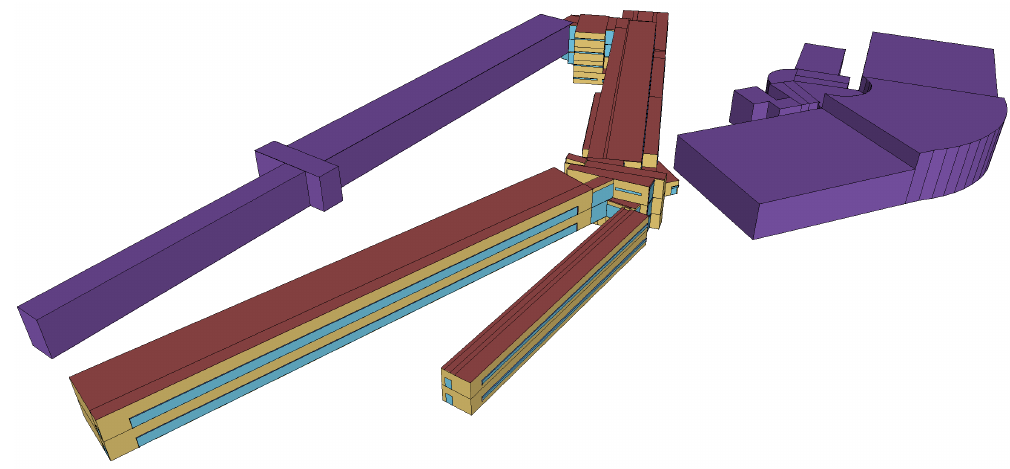
Figure 2. Geometry of the BIM model of the Mining and Energy Engineering School of the University of Vigo in SketchUp.